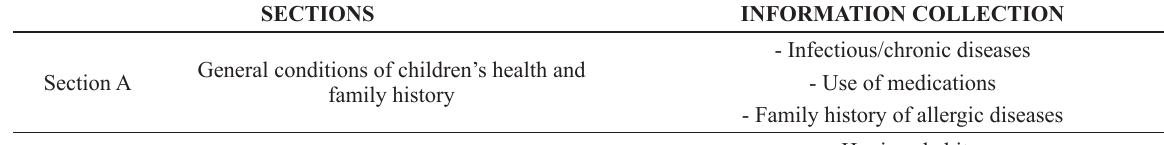
Sections and information covered by the survey